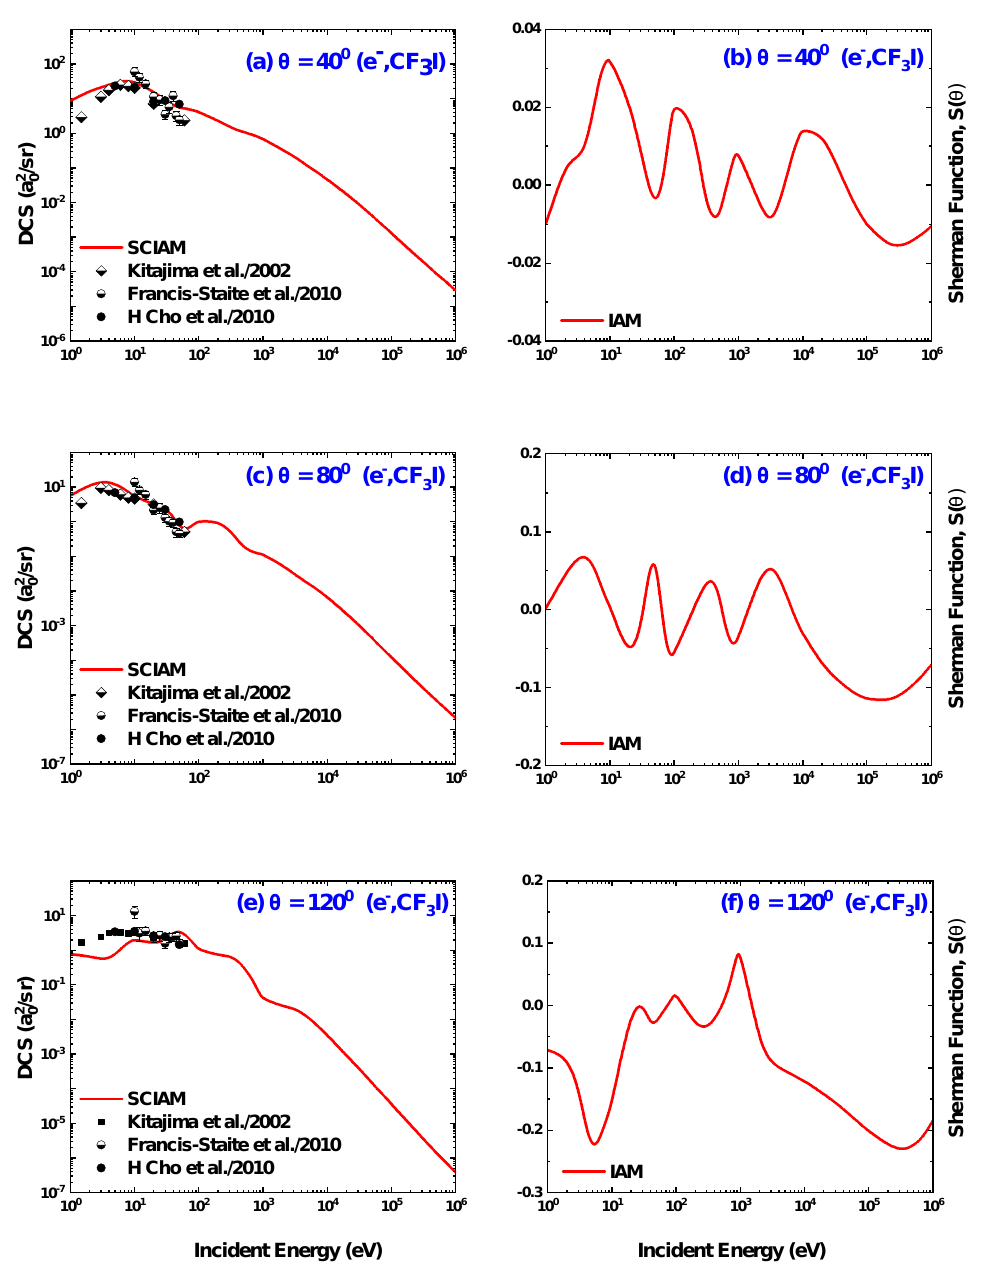
Figure 8. Energy-dependent DCS ( a 2 / sr ) and Sherman function at 40 ◦ , 80 ◦ , and 120 ◦ for the elas- 0 tic scattering of electrons from CF 3 I. Theoretical works: SCIAM (DCS), IAM (Sherman function). Experimental works: Francis-Staite et al. [25], H Cho et al. [26], and Kitajima et al.